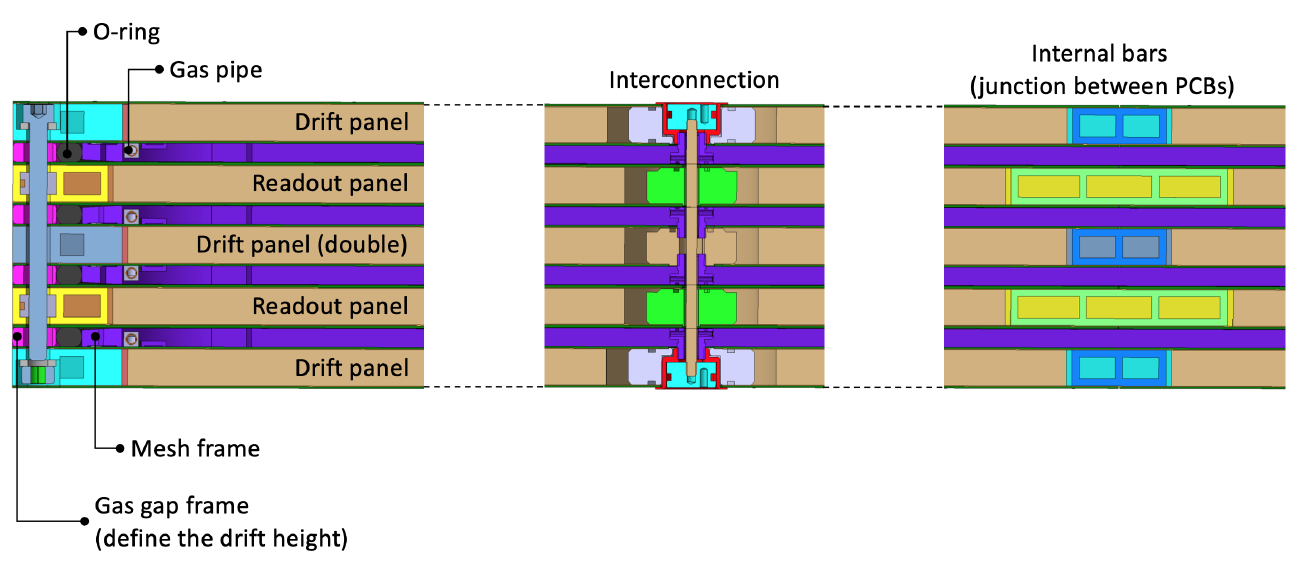
Figure 11. Section of a Micromegas quadruplet with details of the internal components on the edges, at the level of the interconnections and at the junction between